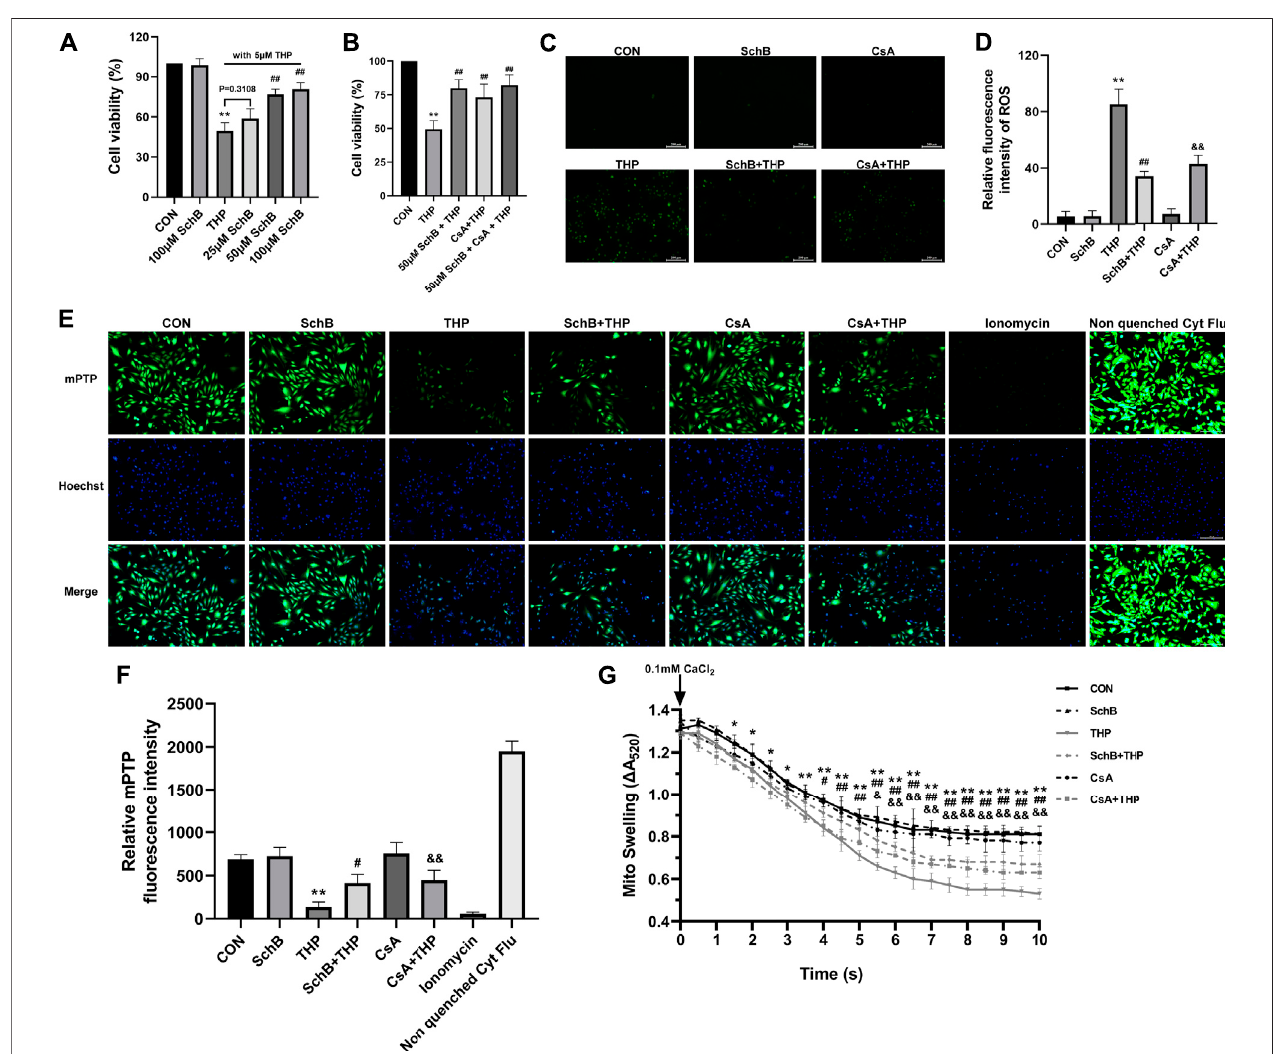
FIGURE 6 | SchB ameliorates THP-induced abnormal expression of apoptosis-related proteins in rat heart. (A) Screening of optimum treatment concentration of SchB. (B) Observation on the effect of coculture of SchB and CsA. (C) ROS staining in each group. (D) Quanti fi cation of relative fl uorescence intensity of ROS in each group. (E) H9C2cellsinCON,SchB,andCsAgroupsshowedbrightgreen fl uorescence,whileonlyweakgreen fl uorescencewasobservedintheTHPgroup.Thegreen fl uorescencewasmoreobviousinSchB+THPandCsA+THPgroups,whichwasgreatlyimprovedcompared withTHP.Ionomycinwasastrongpositivecontrol. Nonquenched Cyt Flu was that the cytoplasmic fl uorescence is not quenched. (F) Fluorescence quantitative analysis. (G) Mitochondrial swelling was analyzed for 10 min. All values are mean ± SD. *p < 0.05 vs. CON , ** p < 0.01 vs. CON , # p < 0.05 vs. THP , and ## p < 0.01 vs THP.